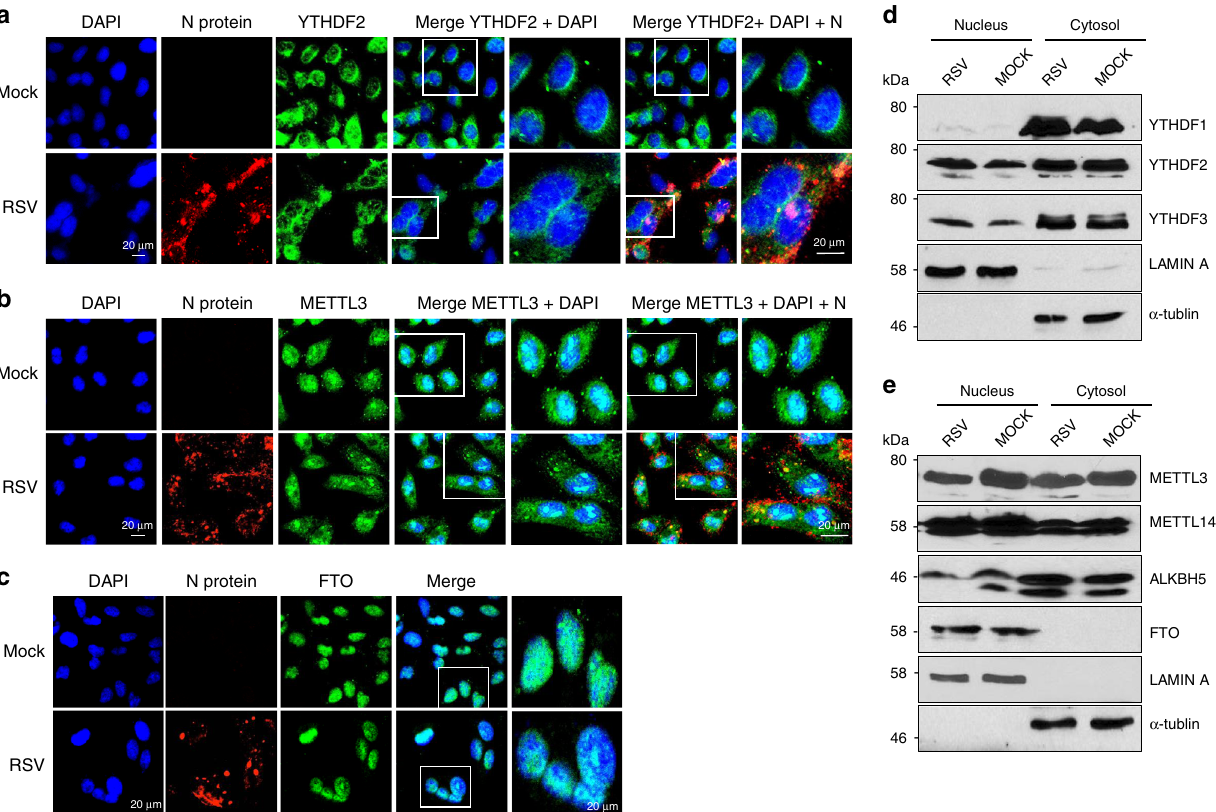
Fig. 6 RSV infection does not alter the m 6 A reader, writer, or eraser protein distribution in cells. HeLa cells were infected by rgRSV at an MOI of 10.0. At 24 h post-infection, mock- or rgRSV-infected cells were stained with anti-reader, writer, or eraser protein antibody (green) and anti-RSV N protein antibody (red), and were analyzed by confocal microscope. Nuclei were labeled with DAPI (blue). Micrographs with ×60 magni fi cation (scale bar of 20 μ m) are shown. a m 6 A reader protein YTHDF2; b m 6 A writer protein METTL3; and c m 6 A eraser protein FTO. d Detection of m 6 A reader, writer, and eraser proteins by Western blot. Nuclear and cytoplasmic fractions were separated from mock- or rgRSV-infected HeLa cells, and were subjected to western blot. Nuclear and cytoplasmic markers were indicated by Lamin A and α -Tubulin, respectively. Representative results from three independent experiments are